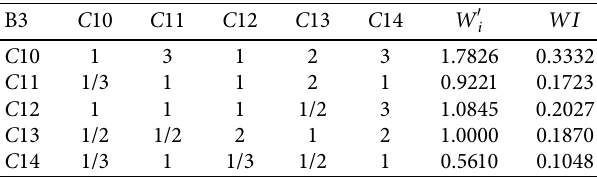
Table 5: B 3- C judgment matrix.